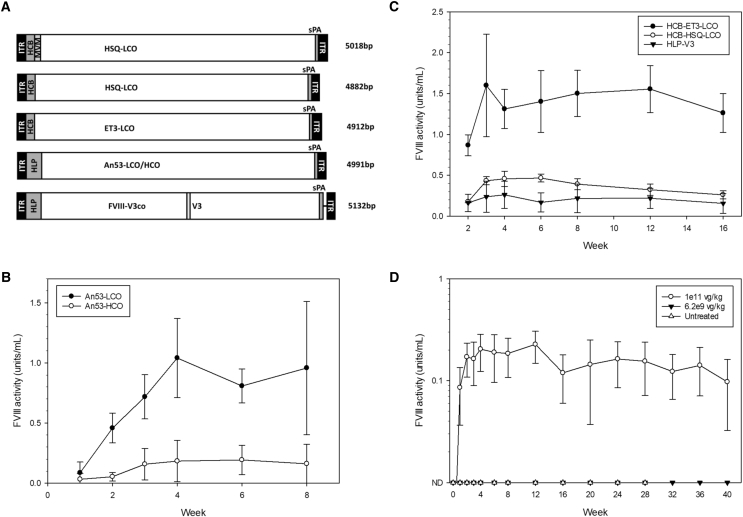
AAV Vector Delivery of Tissue Optimized Transgene Cassettes(A) Schematics of AAV2/8 transgene designs. Straight lines represent DNA sequence of no known function. (B) AAV2/8-HLP-An53-LCO and AAV2/8-HLP-An53-HCO were delivered intravenously to hemophilia A mice at a dose of 1 × 1011 vg/kg (n = 4 per group). (C) AAV2/8 HCB-HSQ-LCO, AAV2/8-HCB-ET3-LCO, and AAV2/8-HLP-V3co were delivered intravenously to hemophilia A mice at a dose of 1 × 1011 vg/kg (n = 3–4 per group). (D) A long-term, dose-finding experiment was performed with varying does of AAV2/8-HCB-MVM-ET3-LCO (n = 3 for all other doses). Data are presented as the mean ± sample SD.